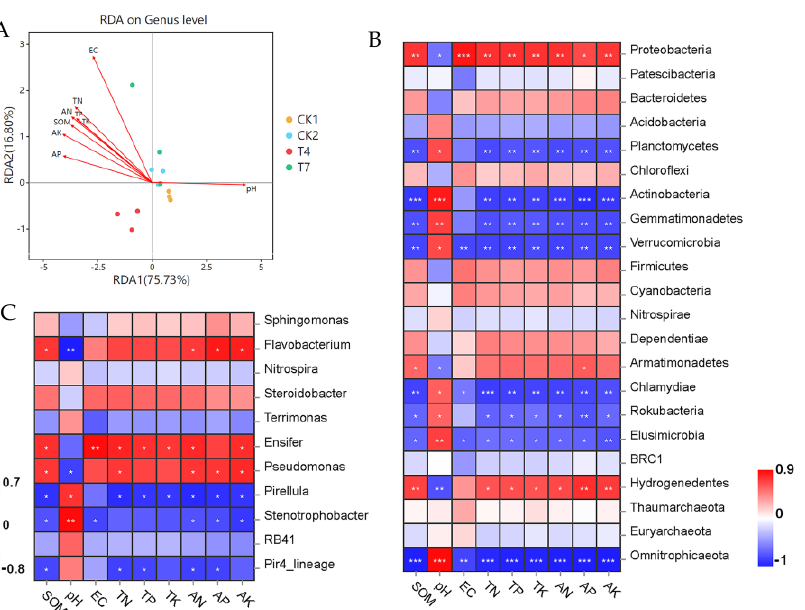
Figure 9. Redundancy analysis (RDA) of soil chemical properties and bacterial communities. ( A ) Phylum level ( B ) and genus level ( C ) bacterial dominant flora and soil environmental factors: Pearson correlation analysis; SOM, soil organic matter; EC, electrical conductivity; TN, total nitrogen; TP, total phosphorus; TK, total potassium; AN, hydrolyzable nitrogen; AP, available phosphorus; AK, available potassium. (The horizontal axis indicates environmental factors, the vertical axis indicates species, and colors from blue to red represent the relative abundance of the functions from low to high; *: significant correlation, p < 0.05; **: highly significant correlation, 0.001 < p < 0.01; ***: highly significant correlation, p <